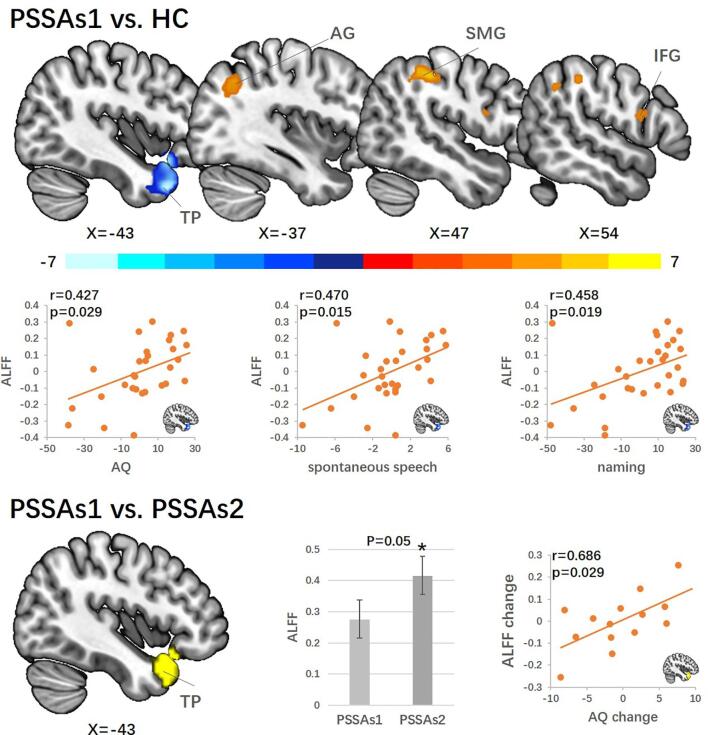
Results of amplitude of low-frequency fluctuations analysis. The comparison between baseline PSSA patients and HCs are shown at the top. Compared to HCs, PSSA patients showed decreased ALFF in the left TP and increased ALFF in the left AG, right SMG, and right IFG. Left TP ALFF value was positively correlated with WAB AQ (p = 0.029), spontaneous speech (uncorrected p = 0.015, FDR p = 0.038), and naming (uncorrected p = 0.019, FDR p = 0.038) scores. The comparison between PSSA patients in session 1 and session 2 was shown on the bottom. PSSA patients showed significantly increased ALFF in the left TP (p = 0.05) after one month. The left TP ALFF change is positively and significantly correlated with WAB AQ change (p = 0.029) in the patients. Note that due to partial correlations, axes show the residuals of parameters. Abbreviations: ALFF: amplitude of low-frequency fluctuations; TP: temporal pole; AG: angular gyrus; SMG: supramarginal gyrus; IFG: inferior frontal gyrus. ‘*’ indicates statistical significance.